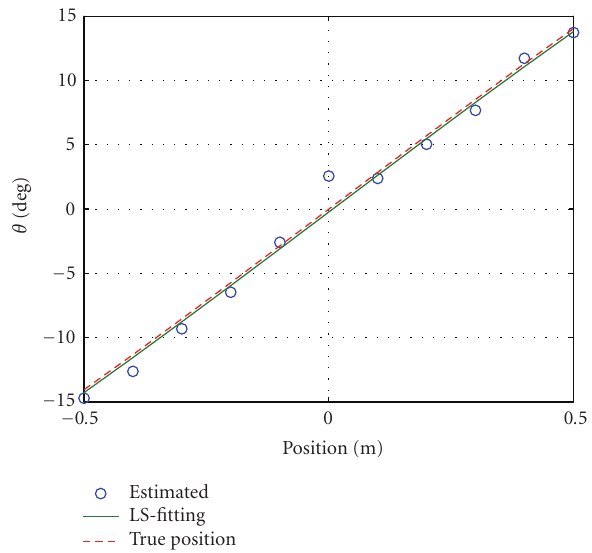
Figure 12: Estimation performance of a moving tag at the 11 posi- tions.